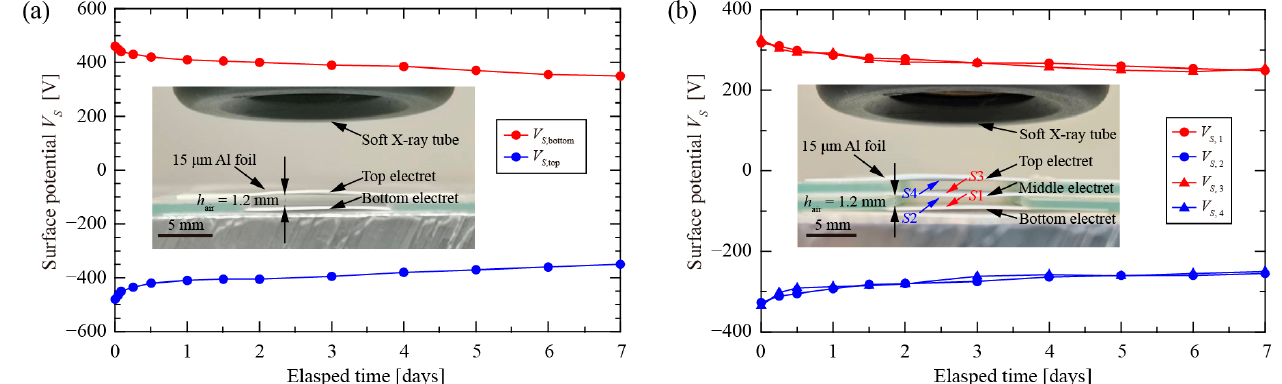
Figure 6. Surface potential of each electret layer inside cellular PTFE electret after soft X-ray charging at V DC = 1.00 kV. ( a ) Specimen with N = 2; ( b ) Specimen with N = 3. PEA-measured space charge profiles of the soft X-ray-charged cellular PTFE electret with h p = 100.0 µ m and h a = 52.3 µ m after a charging time of 20 min are shown in Figure 7. Measurements of space charges were carried out after a 5 min short-circuit period. The appearance of hetero-charges density peaks located at the air–PTFE and PTFE–Al interfaces correspond to trapped charges due to the photoionization of soft X-ray-irradiated air. The charge densities continuously increased with increasing V DC and reached saturation when V DC was above 3.0 kV.